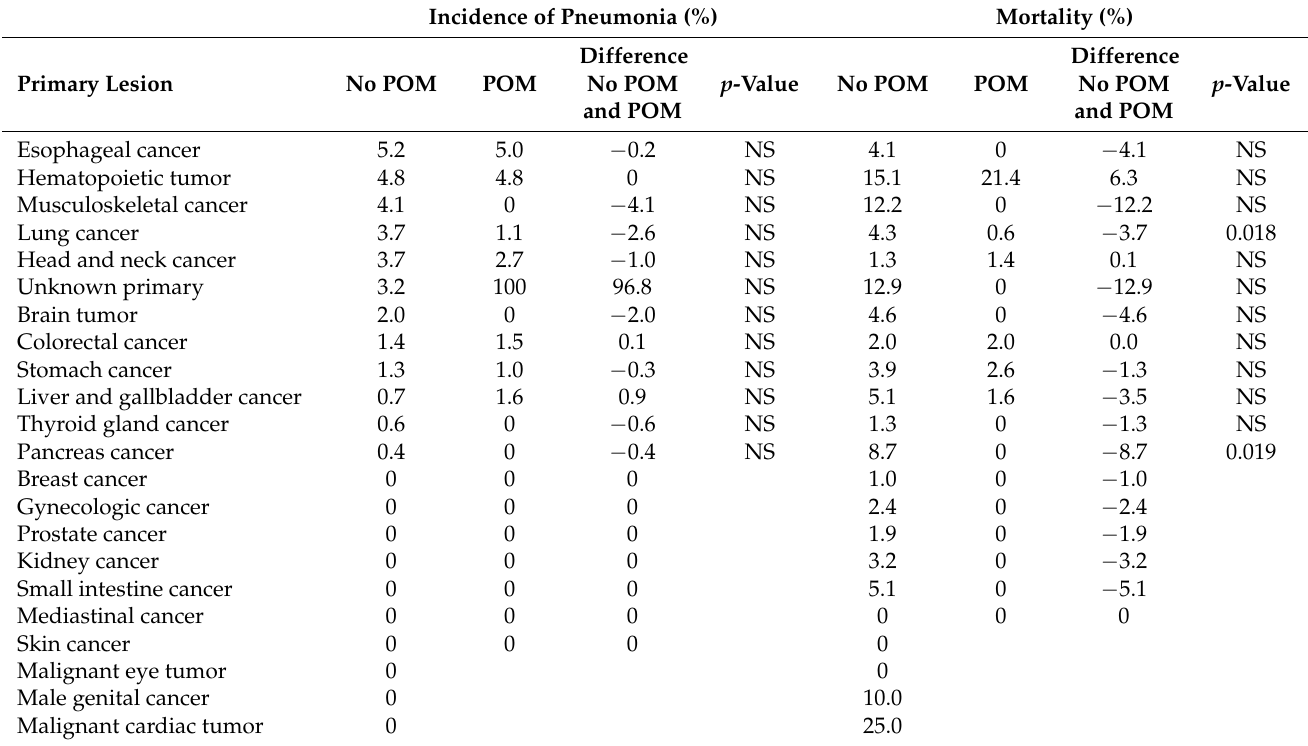
Table 2. Comparison of pneumonia incidence and mortality by the primary lesion.